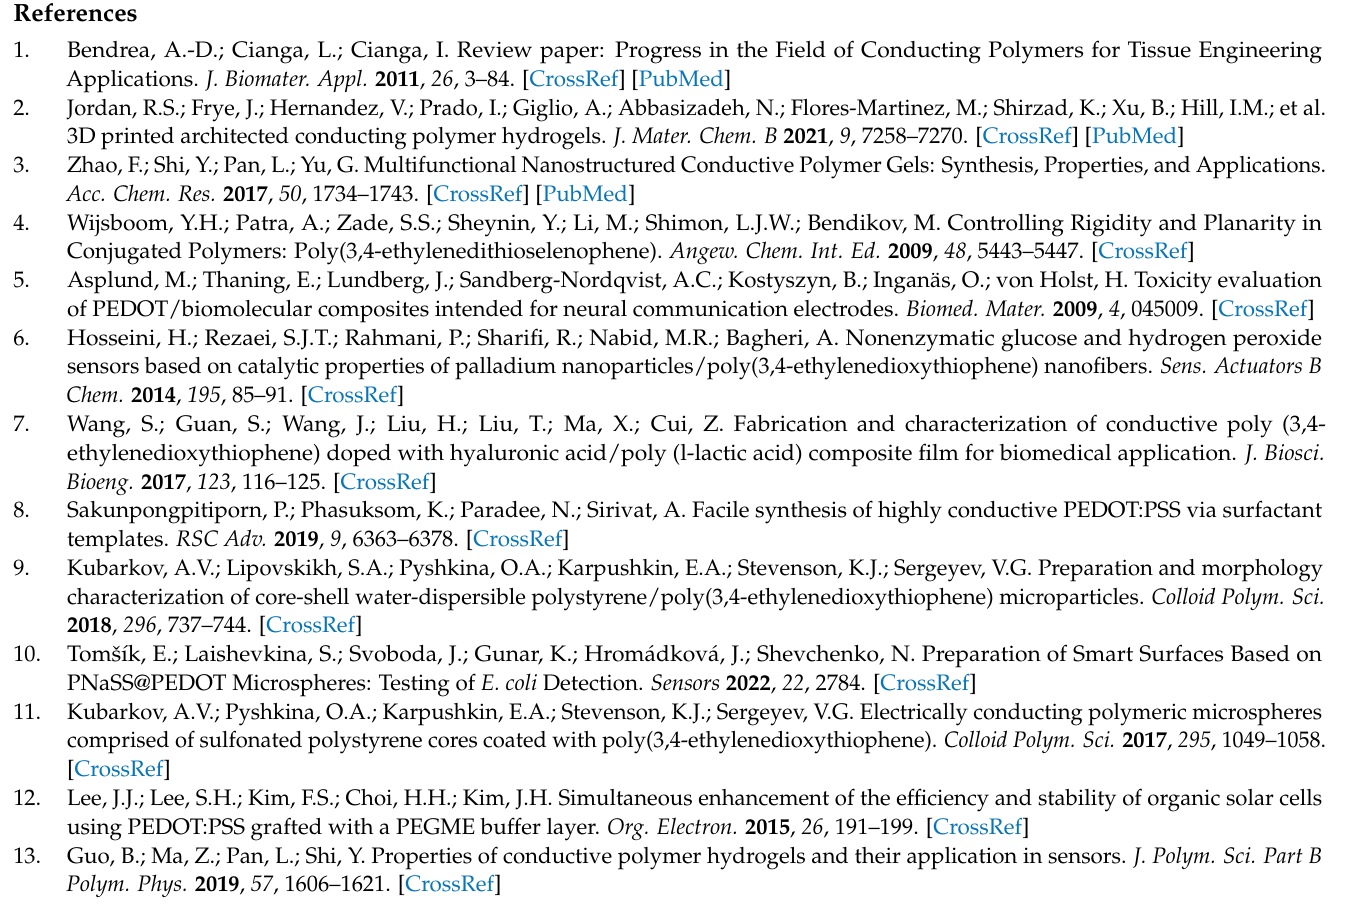
Figure S2: EDX-analysis of P(SBMA-VA); Figure S3: EIS of P(SPM-VA); Figure S4: CVA of P(SBMA- HEMA); Figure S5: CVA of P(SBMA-VA); Figure S6: The simulation circuit of Rct in EIS